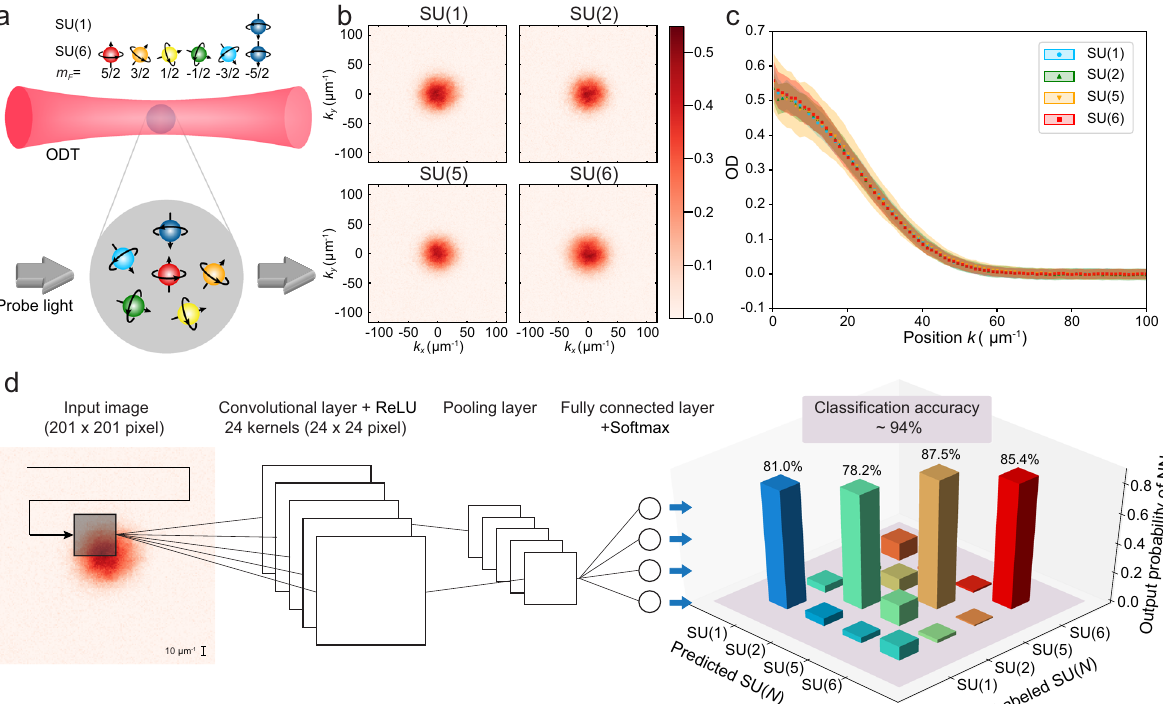
Fig. 1 Distinguishing SU( N ) fermions based on spin multiplicity by machine learning. a Schematic of preparing SU( N ) gases in the optical dipole trap (ODT). The momentum distribution of the SU( N ) Fermi liquid of 173 Yb atoms with tunable spin con fi guration is recorded. The collected datasets are then fed into the NN as the input images for classi fi cation. b Examples of single experimental images of SU( N ) gases. c Radially averaged optical density (OD) pro fi les in different SU( N ) gases. The shaded region represents the fl uctuation of the density pro fi les. d Experimental images of SU( N ) gases are loaded into the neural network with one single convolutional layer. The black line and window represent how the kernel slides across the image. The output layer classi fi es the image into one of the class (i.e., SU(1), SU(2), SU(5), SU(6)) resulting in a classi fi cation accuracy around 94%. For each input image, NN outputs probabilities of different SU( N ) with the highest value of the correct class. The output probabilities of NN are averaged over the test